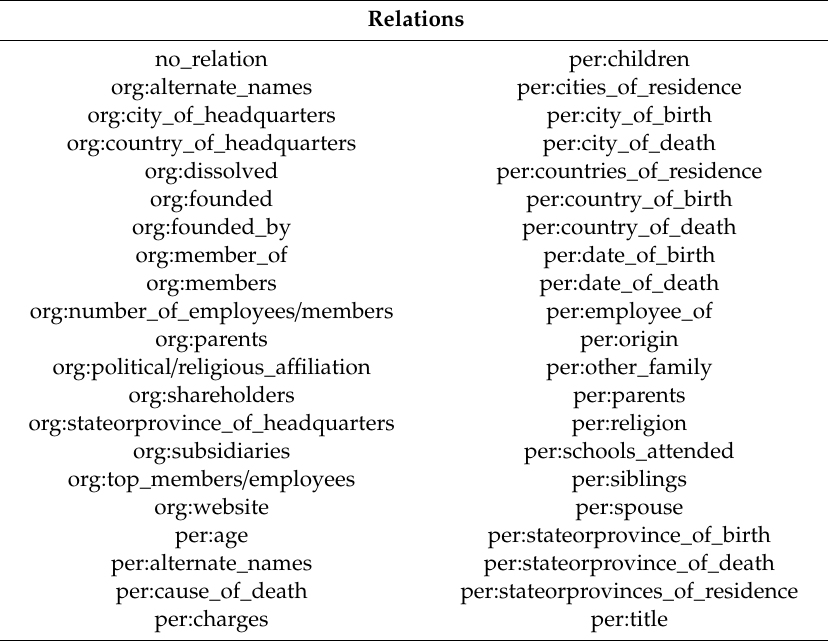
Table 2. Relations in TACRED dataset.